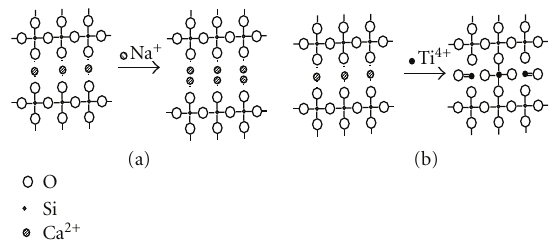
Figure 7: Schematic diagram representing the replacement of Ca ion by Na or Ti ion in 58S sol-gel bioactive